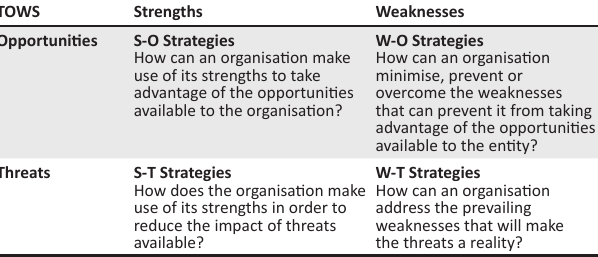
TABLE 2: Strengths, Weaknesses, Opportunities and Threats analysis matrix. TOWS